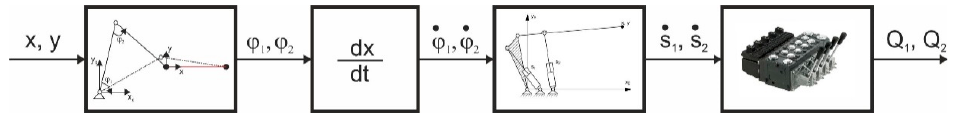
Figure 6. Scheme of determining the control signals for the piston rod movement of the boom and arm hydraulic cylinders.